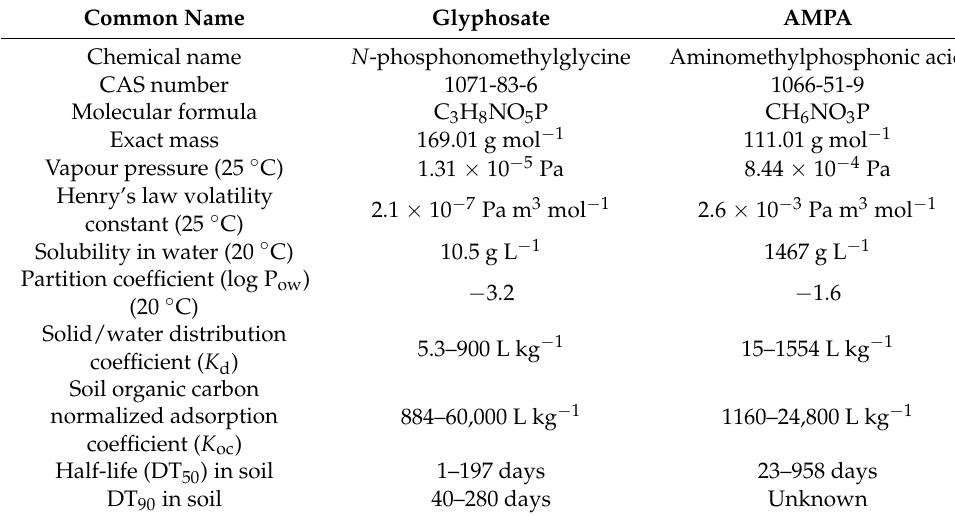
Table 2. Properties of glyphosate and its metabolite